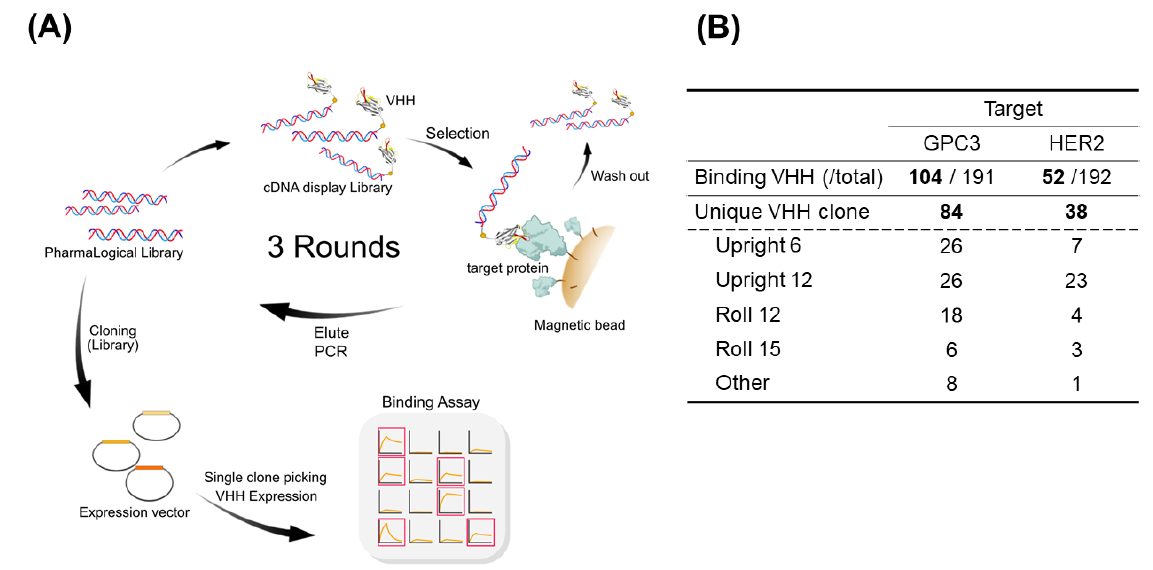
Figure 4. ( A ) Schematic of the screening flow using “ The Month ” platform. The cDNA display selection strategy is used to isolate VHHs that bind to target molecules from the PharmaLogical library. The PharmaLogical Library, with > 1.0 × 10 13 diversity, was made into a cDNA display molecule with genotype and phenotype correspondence. Only the cDNA display molecules that bind to the target protein are immobilized on the magnetic bead via the target protein, and the unbound cDNA display molecules were washed away. The DNA of the recovered cDNA display molecule was amplified by PCR, and the PCR product was used as a template in the next cycle. Three-cycle selection was conducted with these series of flows as one cycle. The DNA Library subjected to the selection cycle was cloned into a protein-expression vector, and each clone was expressed. VHHs in the culture supernatant were collected and the binder was identified using Octet384. ( B ) The number of binding VHHs detected as hit clones in the primary binding assay is shown. Unique VHHs are clones detected as hit clones but that do not have duplicate sequences. Unique VHHs were derived from four libraries: Upright 6 , Upright 12 , Roll 12 , and Roll 15 . VHH clones whose origin could not be determined due to mutations in the screening process were designated other.